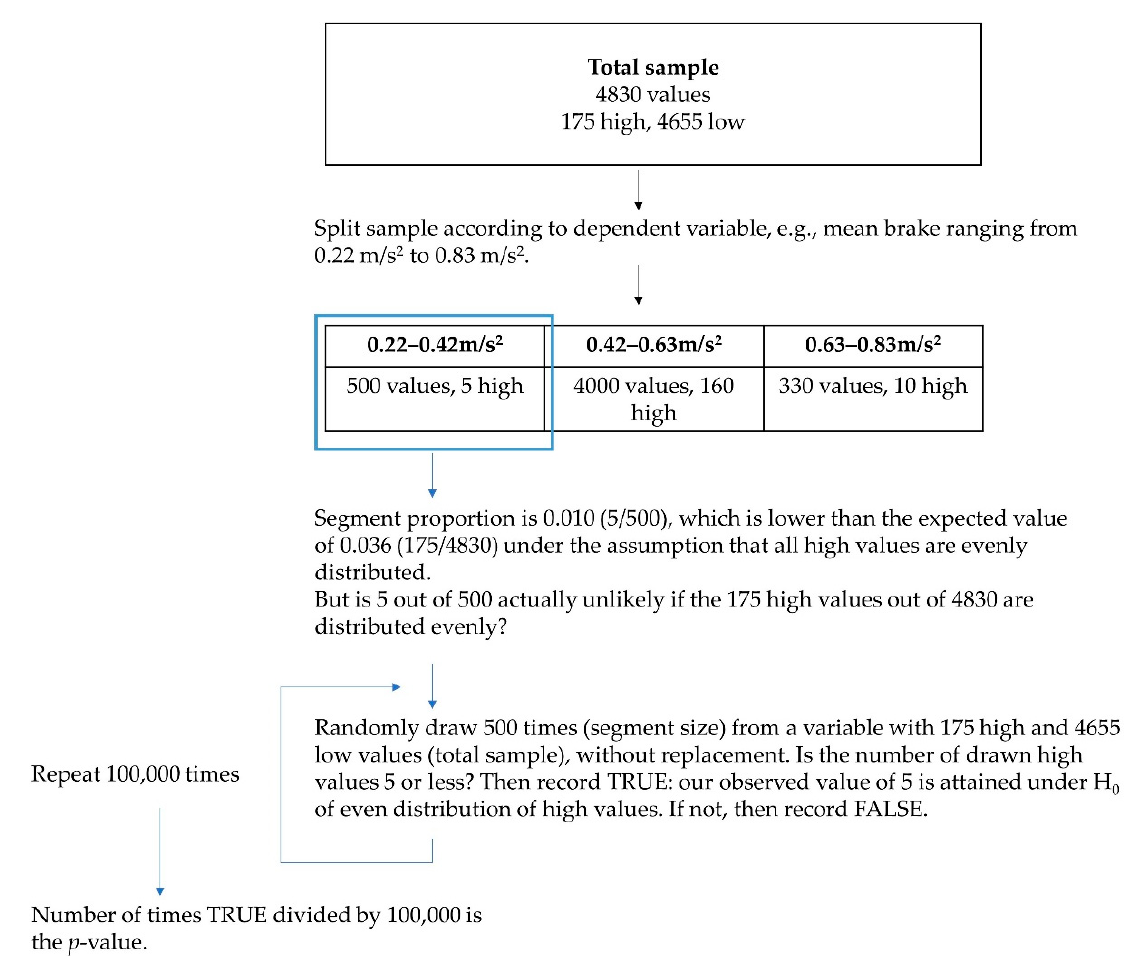
Figure 12. The p -value is calculated per segment by comparing the observed number of high values with the number expected if the high values are distributed evenly.